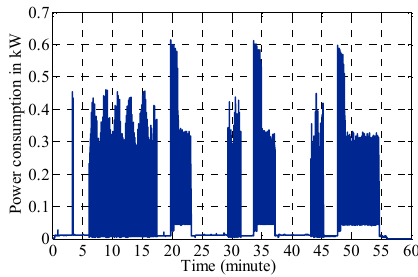
Figure 20. Actual power consumption curve of WM load.